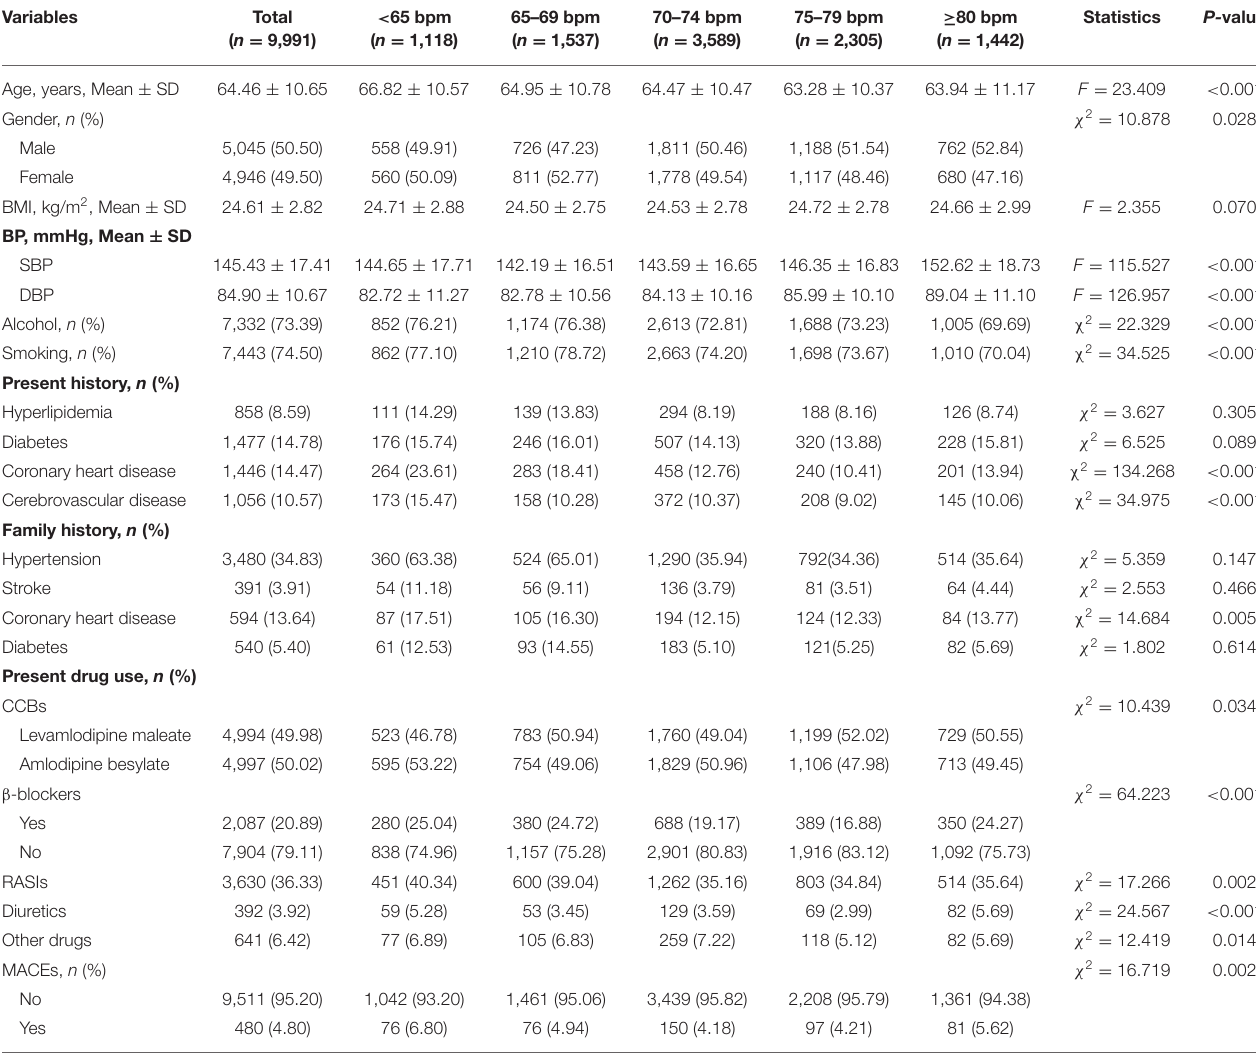
TABLE 1 | Characteristics of hypertensive patients at different heart rate levels.